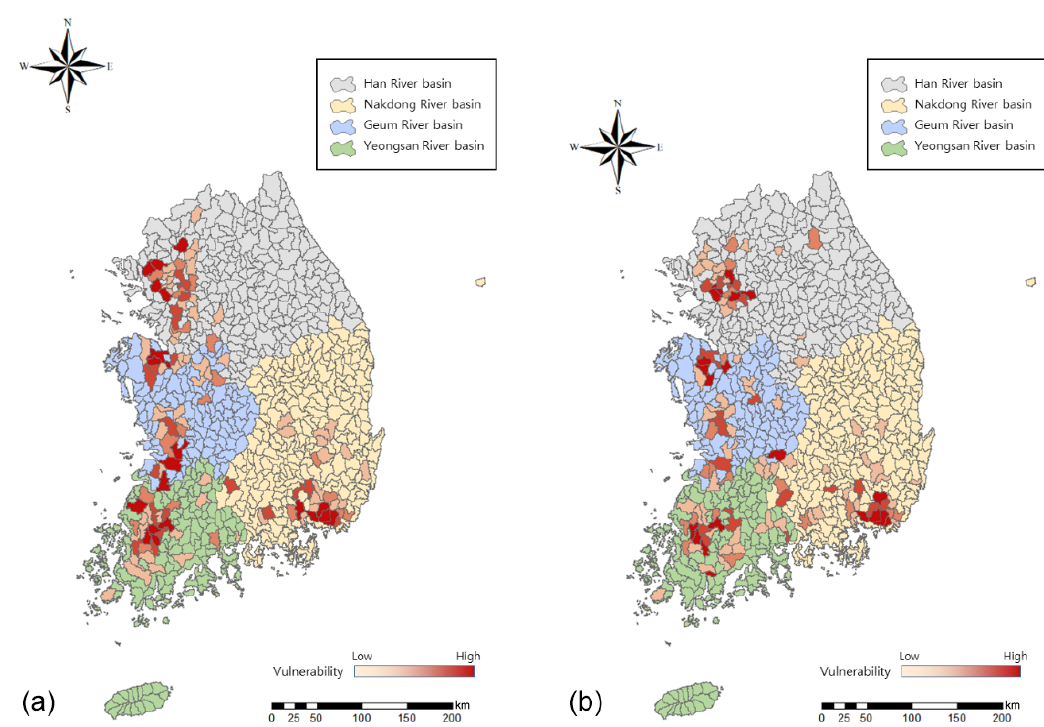
Figure 5. Top 30 small watersheds of diffuse pollution vulnerability for each of the four large watersheds.